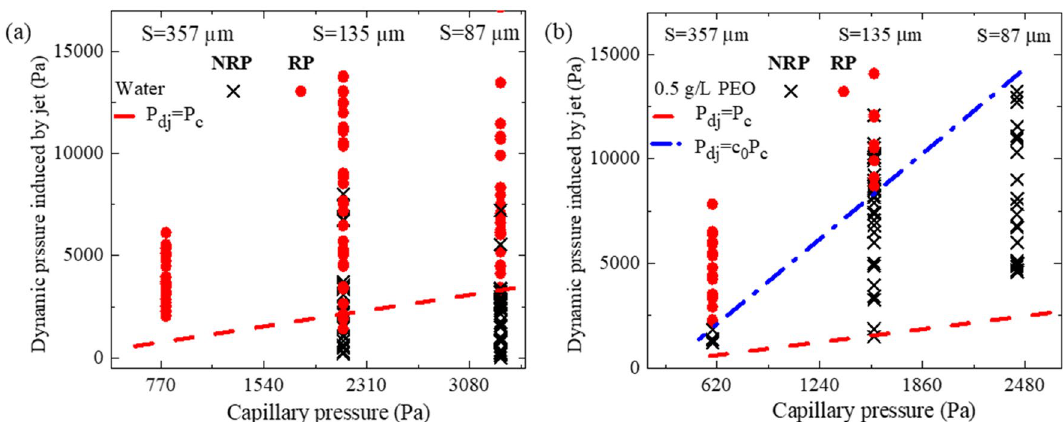
Figure 2. Diagram of the penetration during the reoiling in terms of dynamic pressure induced by jet 3 / 2 R 1 / 2 4 γ/ S cos (θ γ − 1 / 2 v 3 ( P Dj ∼ ρ a ) for ( a ) Water droplet, ( b ) 0.5 g/L, PEO j j ) versus the capillary pressure aqueous droplet. The symbols represent different spray phenomena, the solid symbols show the recoil penetration, and the cross symbol (x), shows no recoil penetration. The dashed line shows P Dj = P c and the dashed-dotted line shows P Dj = c 0 P c when c 0 is the correction